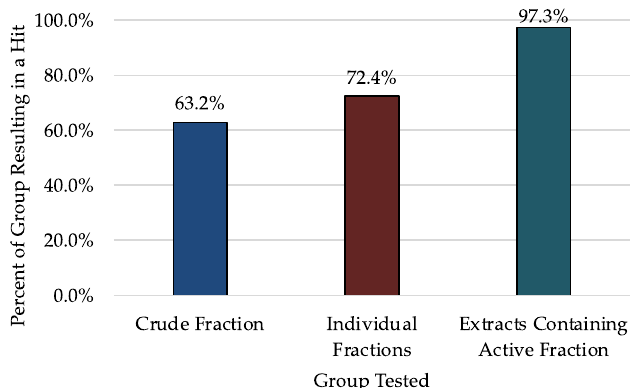
Figure 3. Comparison of hit rates for each extract with or without pre-fractionation. While 63.2% of crude extracts have at least 1 hit, 72.4% of fractions coming from these crude extracts result in a hit. Moreover, after-prefractionation, 97.3% of all extracts will produce a fraction with a hit.